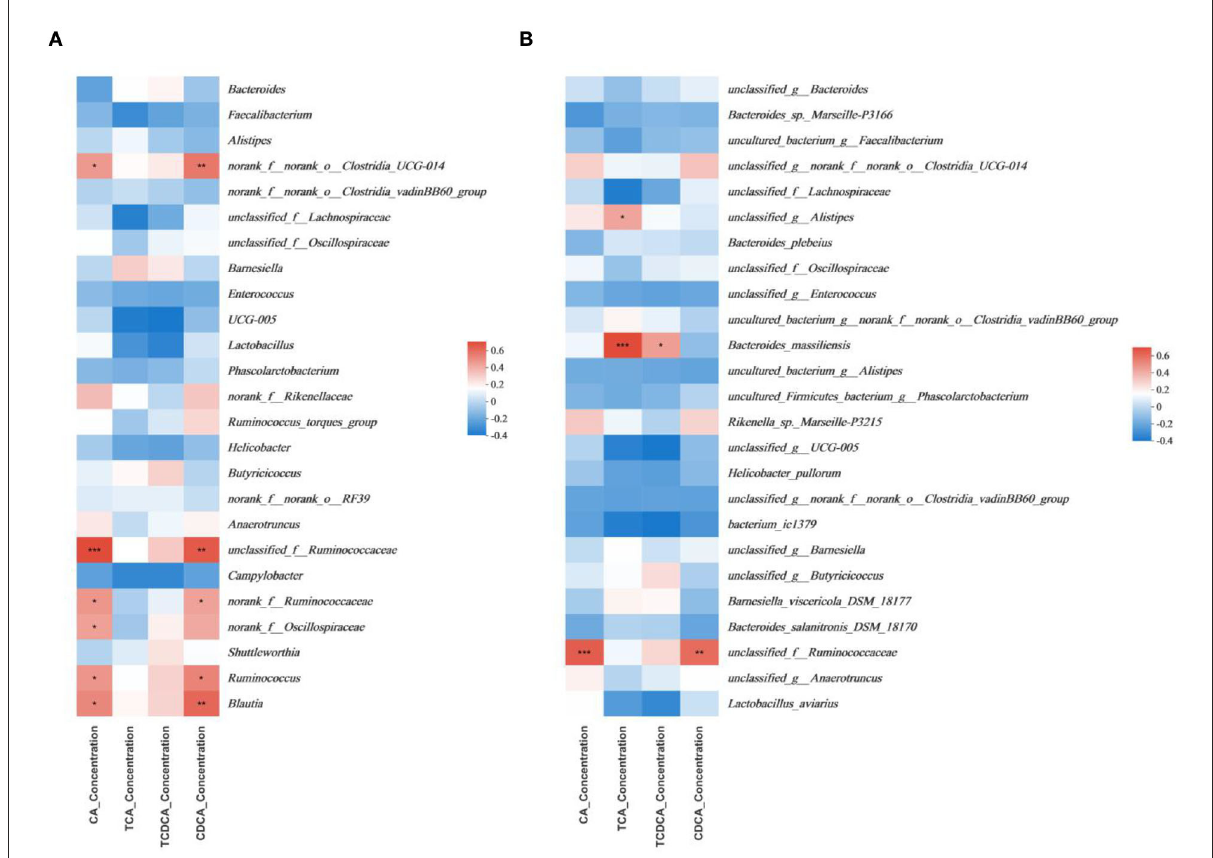
FIGURE8 Significant associations between intestinal microbial and sample metadata of digesta bile acids ( n = 6). (A) genus; (B) species. Cells that denote associations are colored (red or blue) and overlaid with asterisks which show statistically significant differences (*, P < 0.05; **, P < 0.01;